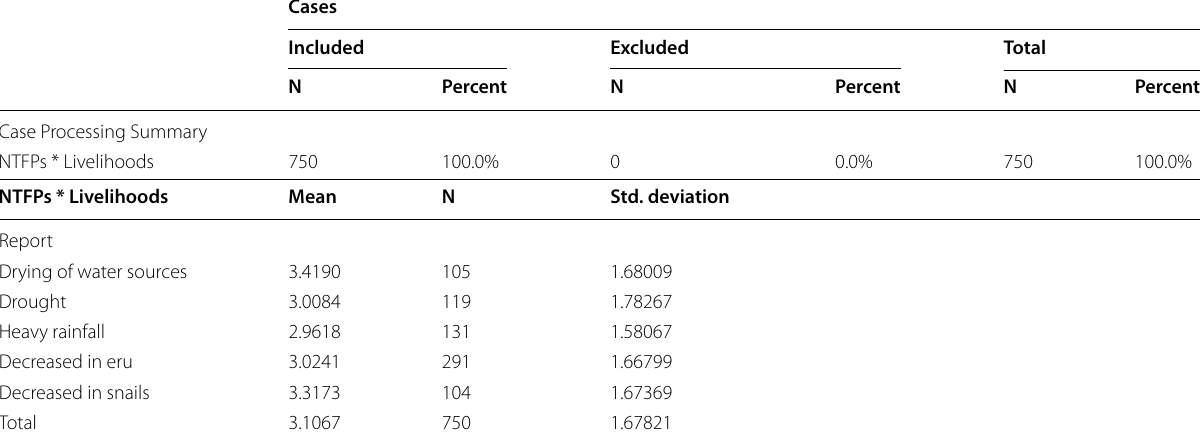
Table 5 The Means and STD deviation of impacts of climate change on NTFPs